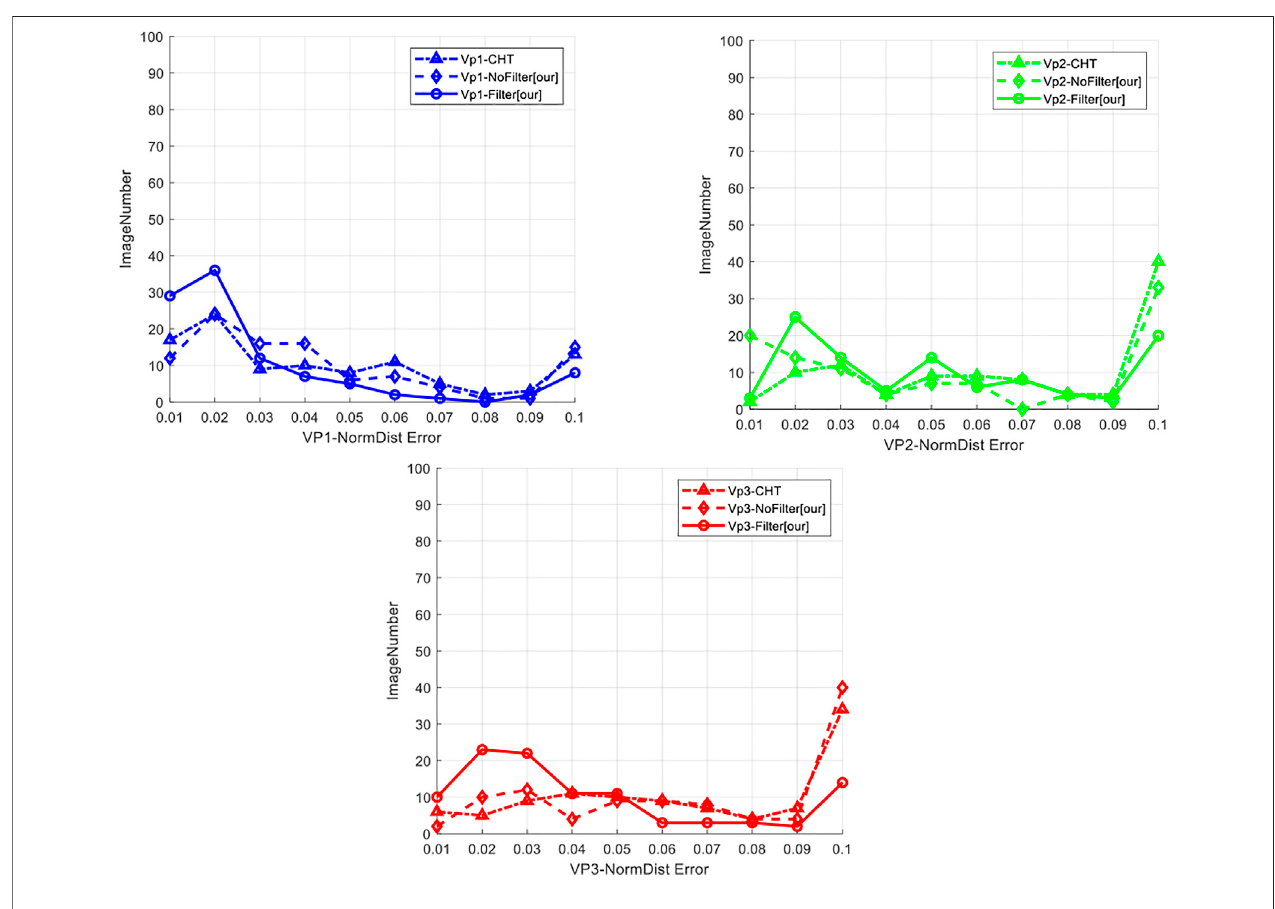
FIGURE 12 | Error distribution diagram for three kinds of vanishing points.